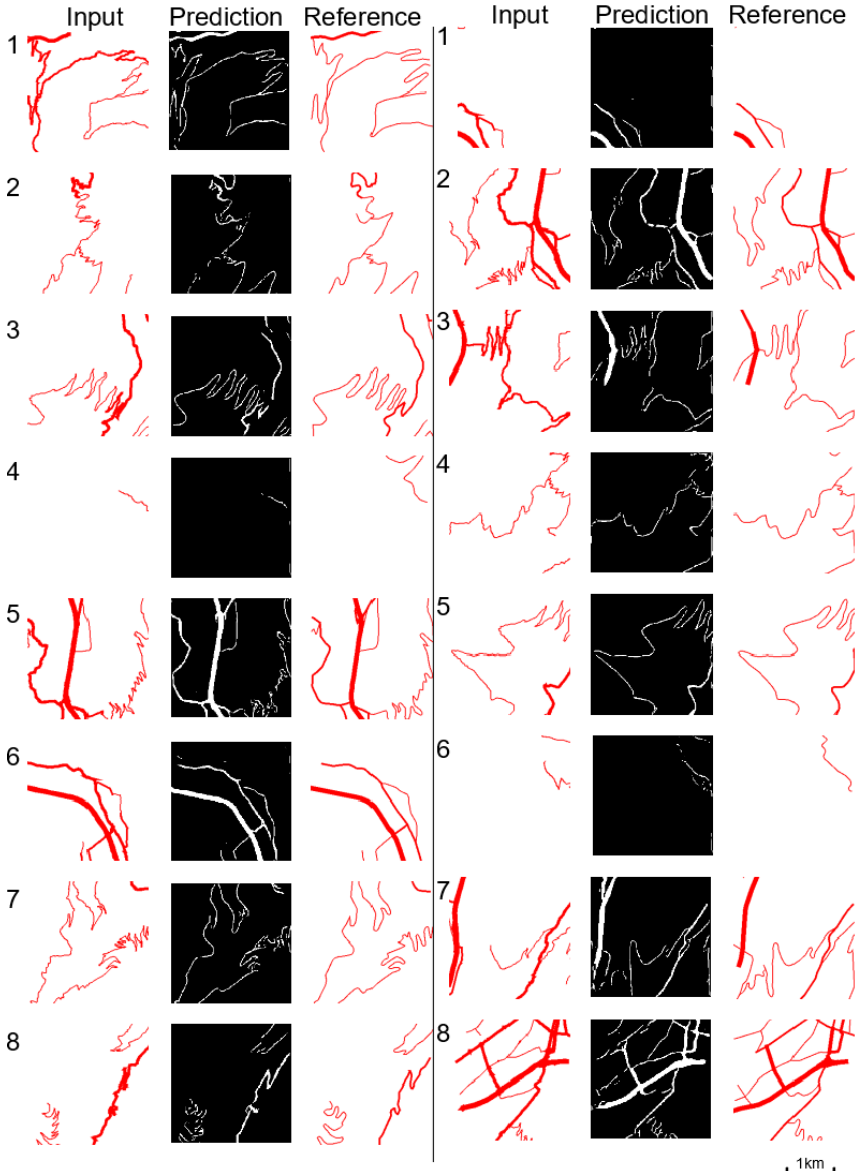
Figure 8. Model prediction on validation